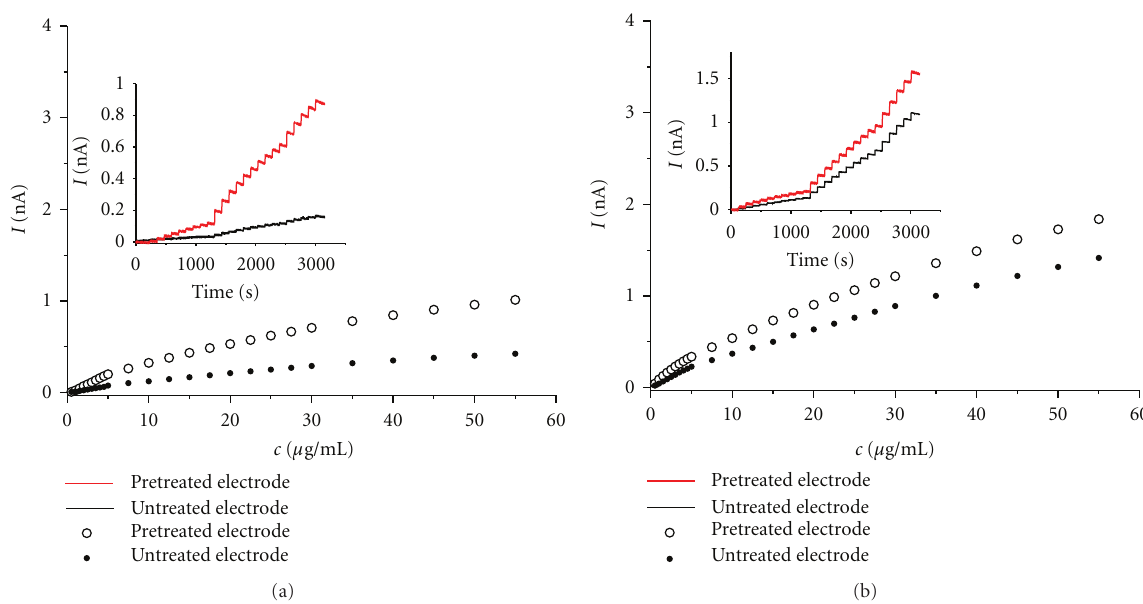
Figure 2: Calibration curves for gallic (a) and ca ff eic acid (b) on pretreated and native carbon fiber electrodes. Inset: actual amperometric response curves determined in stirred mobile phase. Applied potential: 1200 mV (versus Ag/AgCl).